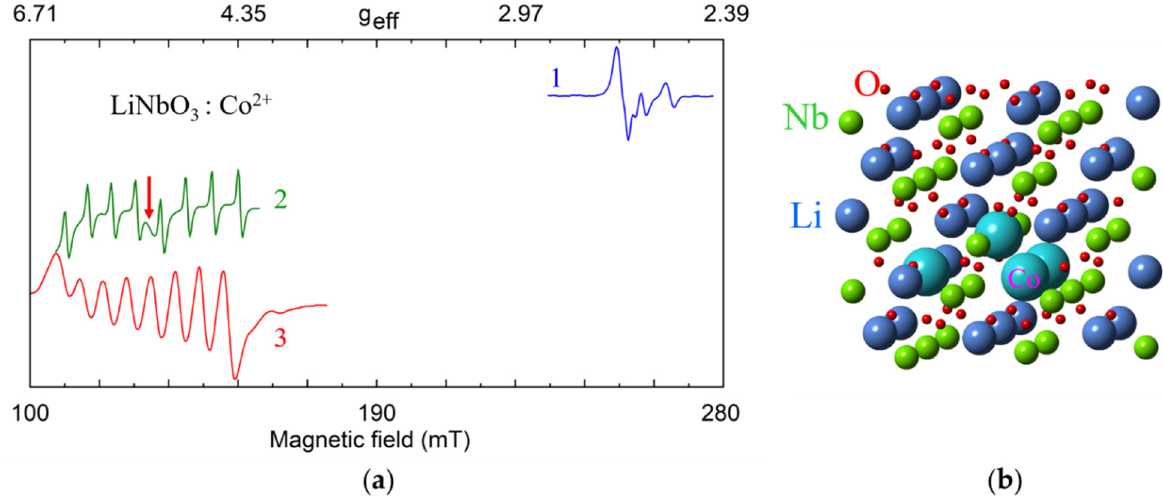
Figure 10. ( a ) Measured EPR spectra of Co 2+ , X-band, T = 5 K. 1—sLN, B||z ; 2—sLN, B||x ; 3—cLN, B||x . The red arrow indicates an additional line assigned to clusters of Co 2+ ions. ( b ) Possible model for a cluster of four Co 2+ ions substituted for one Nb 5+ and three Li + ions.